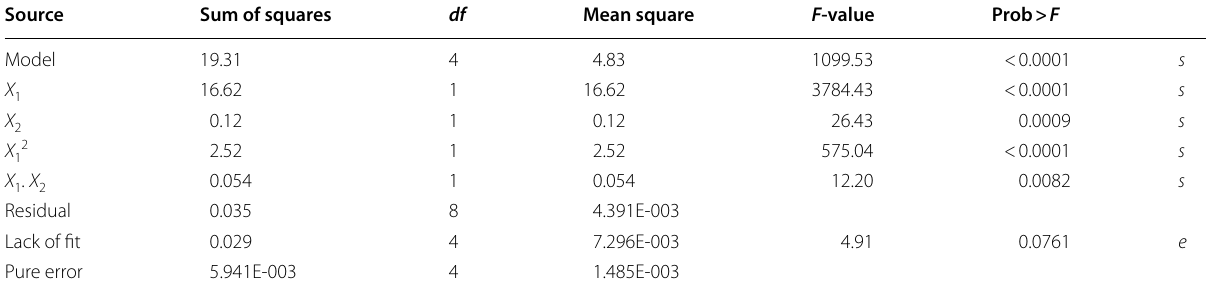
Table 7 ANOVA results for the